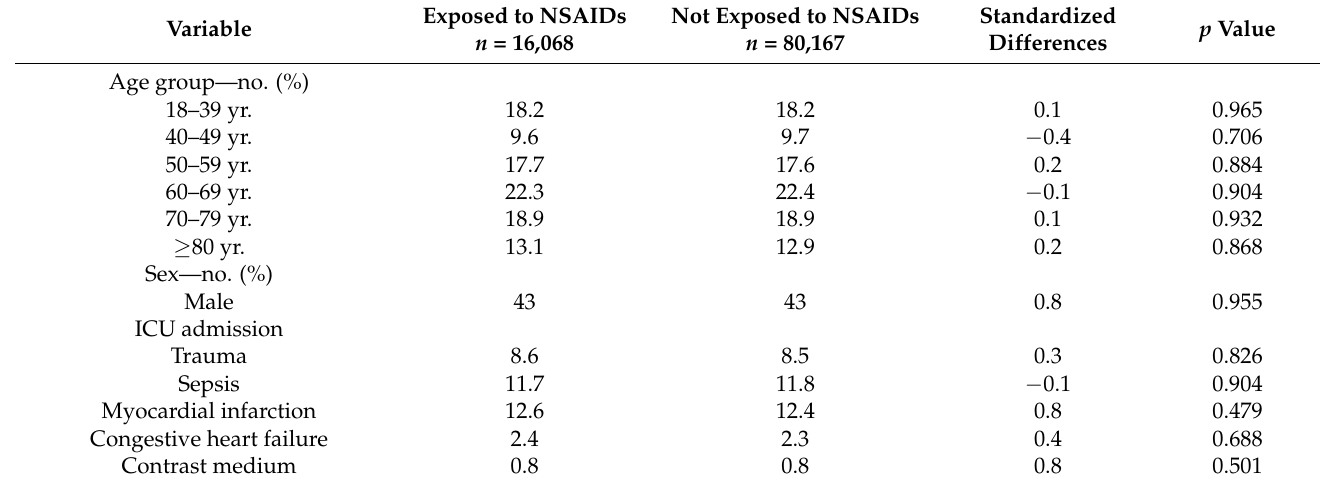
Table 2. Baseline characteristics for each of the groups, after